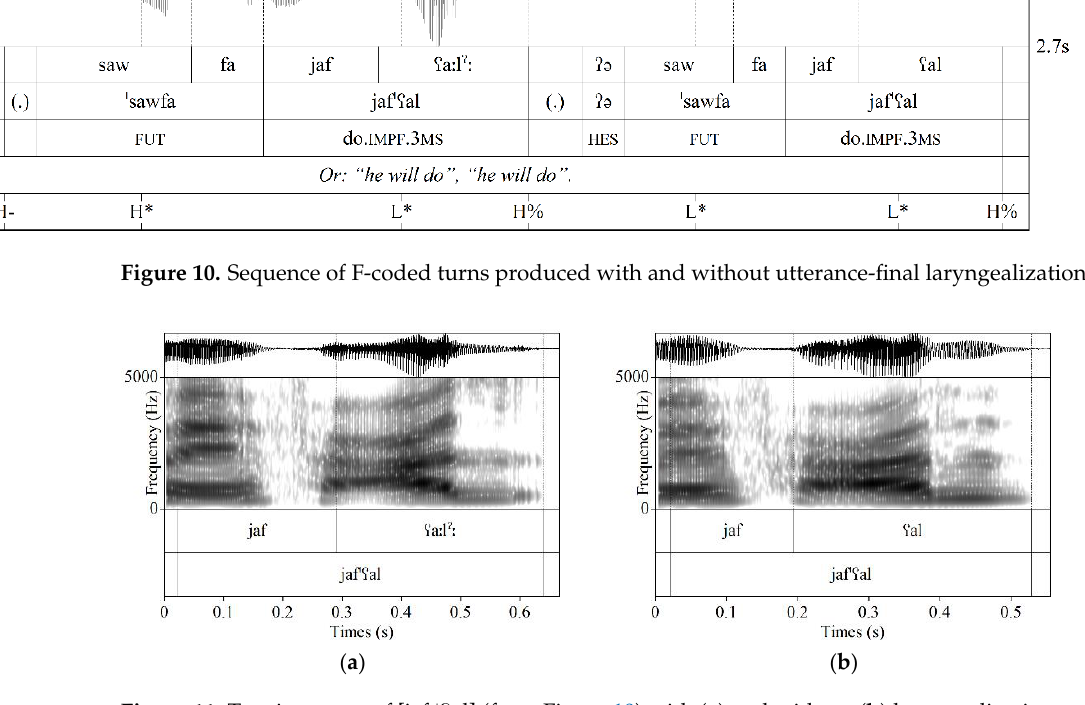
Figure 11. Two instances of [jaf. ˈʕ al] (from Figure 10) with ( a ) and without ( b ) laryngealization.